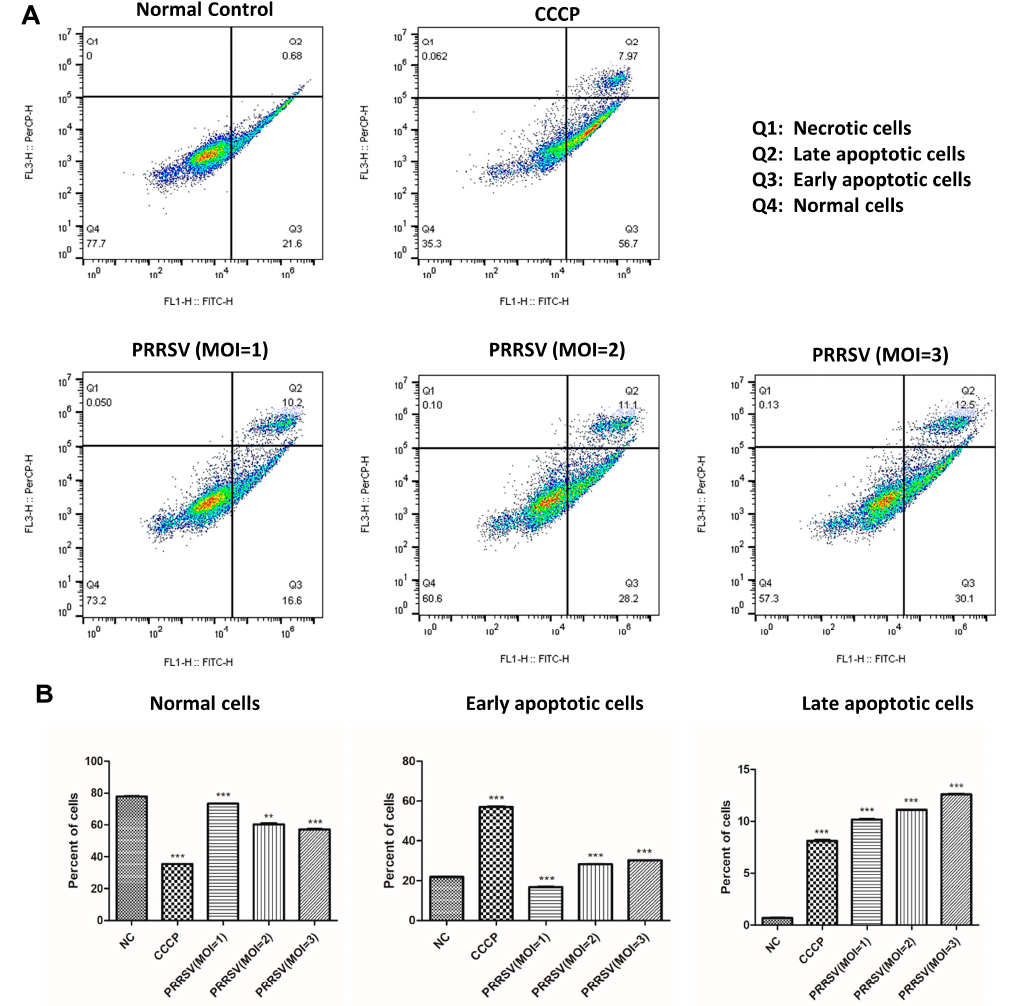
Figure 7. PRRSV induced the apoptosis of the PTR2 cells. Apoptosis ratio analysis of the PTR2 cells with different treatments. The 5 µ M carbonyl cyanide m-chlorophenyl hydrazine (CCCP) for 30 min was used as the positive control and untreated cells were used as the negative control. The experimental group was infected with different doses of PRRSV ( A ). Bars show the ratio of normal cells, early apoptotic cells, and late apoptotic cells in each group ( B ). ** p < 0.01 and *** p < 0.001.